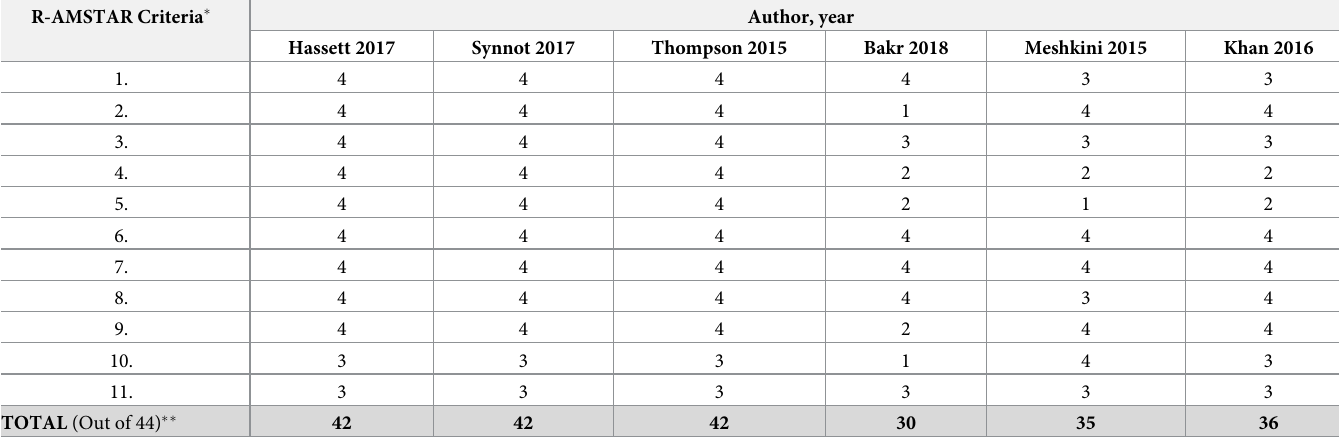
Table 1. Quality assessment (R-AMSTAR) � of included systematic